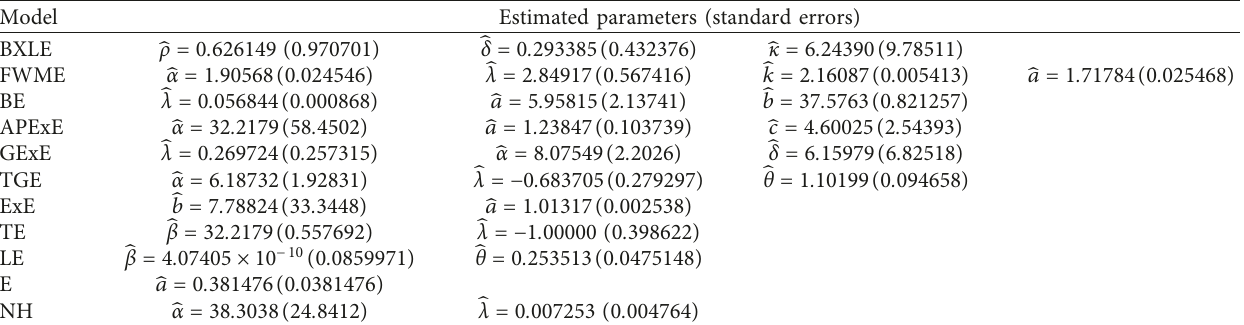
Table 10: Estimated parameters with their standard errors of the BXLE model and other fitted models for second dataset.